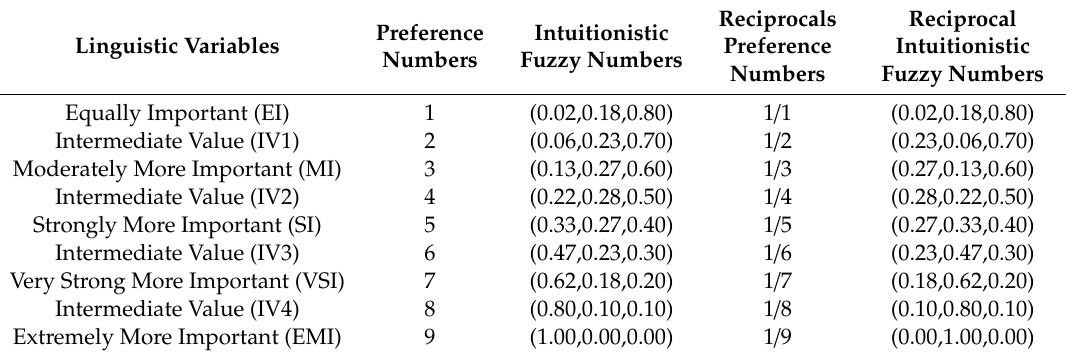
Table 2. Linguistic variables for pairwise comparison [31].